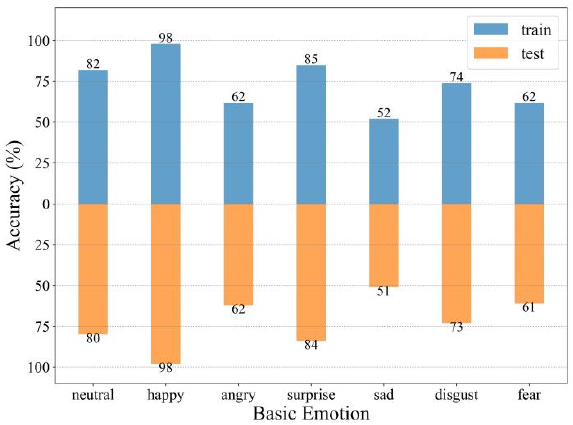
Figure 2. Accuracy of seven kinds of facial emotional recognition. The training accuracies of normal, happy, angry, surprise, sad, disgust, and fear emotions were 82%, 98%, 62%, 85%, 52%, 74%, and 62%. The test accuracies of normal, happy, angry, surprise, sad, disgust and fear emotions were 80%, 98%, 62%, 84%, 51%, 73%, 61%. The proposed facial emotion recognition algorithm had a high detection effect on seven facial